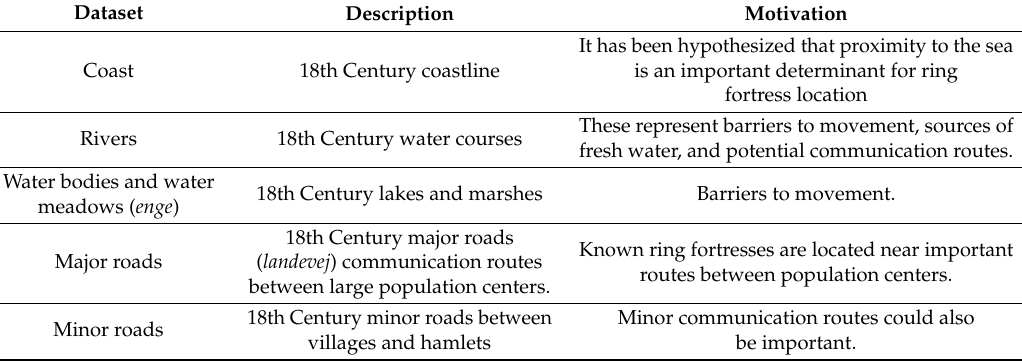
Table 2. Vectorized data from the first nation-wide Danish maps (Videnskabernes Selskabs kort [44]).